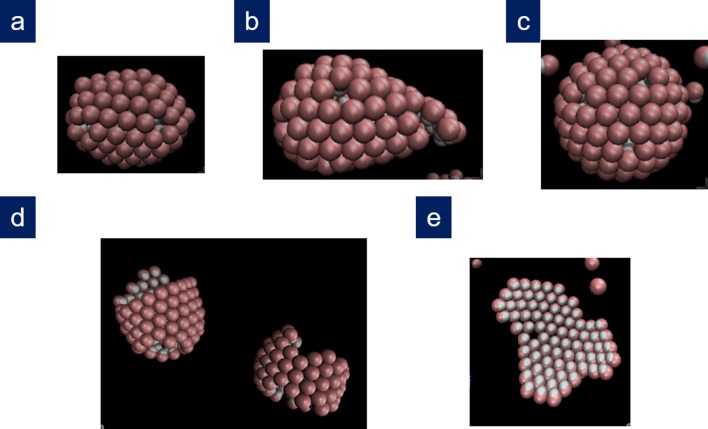
Other structures obtained in the simulations.(a) Bullet-shaped shell and (b) conical shell obtained in two different repetitions for γ=224, λ=0.00069, with m=36, n=18, ν=1.345, α=0.4 and ρ=0.02; (c) T = 13 icosahedral shell obtained for γ=100, λ=0.0005246, with m=36, n=18, ν=1.40, α=0.1 and ρ=0.02; (d) coexistence between a cylinder and a partial spherocylindrical shell obtained for γ=900, λ=0.0005246, with m=36, n=18, ν=1.40, α=0.3 and ρ=0.02; (e) branched ribbon-like structure (Köhler et al., 2016) obtained at low values of the scaled line tension for γ=71, λ=0.00031, with m=36, n=18, ν=1.47, α=0.1 and ρ=0.0125.